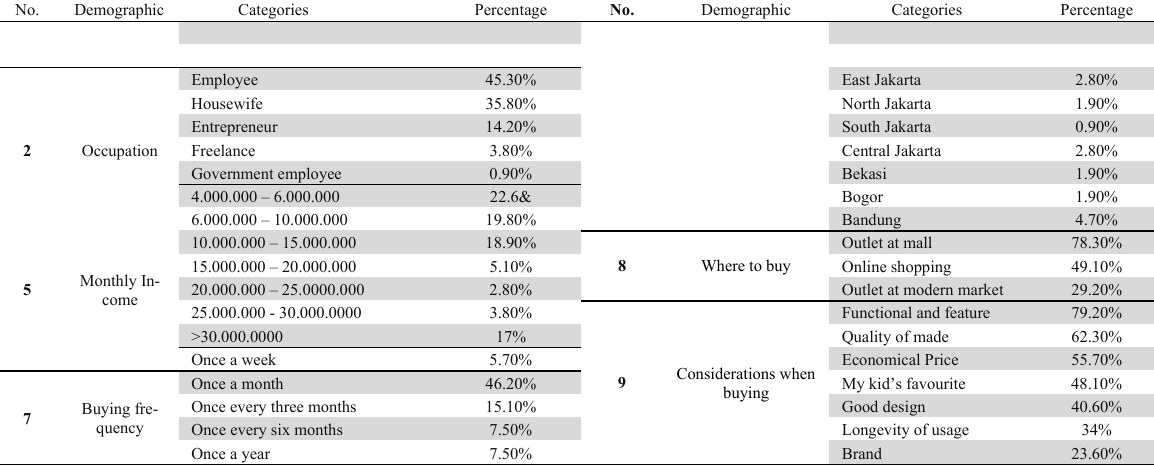
Demographic characteristics of survey non-renters (Continued)